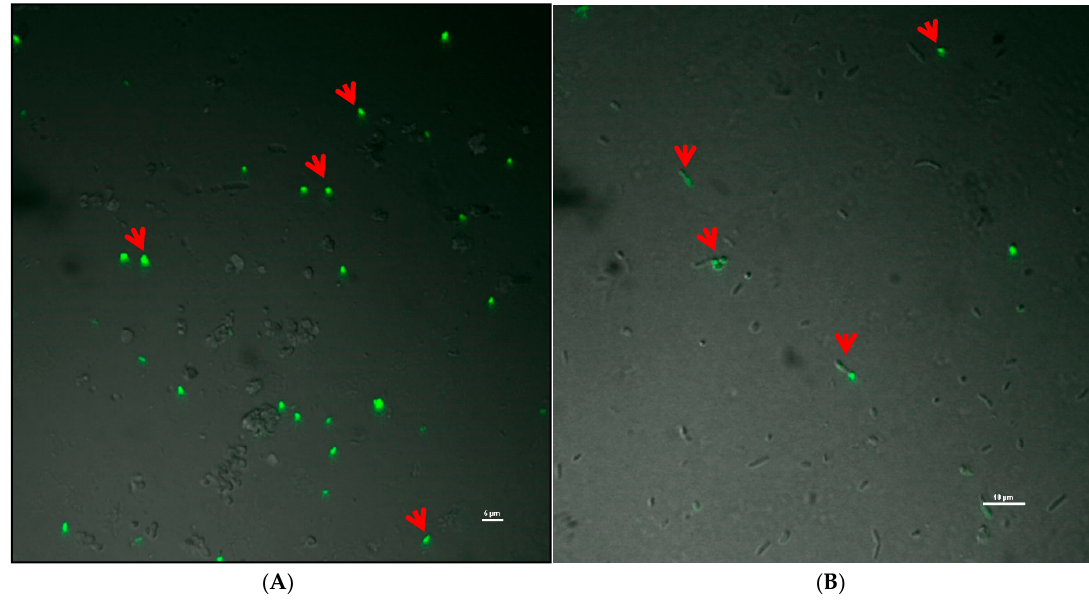
Figure 5. Live–dead cell imaging using SYTO-9 and propidium iodide under confocal scanning laser microscope; arrow indicating live cell signals, ( A ) cells from extract diffusing zone (induced zone), and ( B ) cells from region away from the diffusion zone.